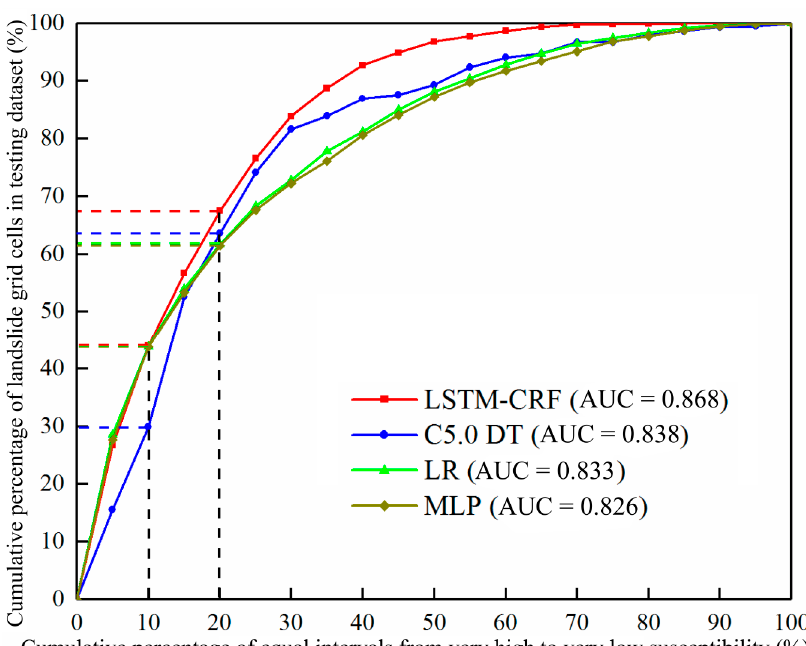
Figure 8. Prediction rate curves of LSIs calculated by the four models.